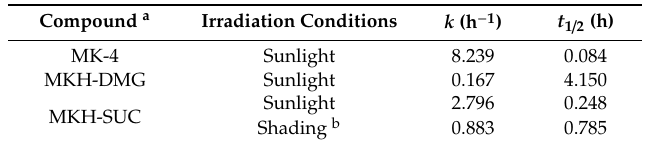
Figure 2. Photostability of MK-4 and MKH derivatives (1 µ M in ethanol) in artificial sunlight (12,000 lx) at 25 °C. ( A ) ○ : MK-4 and ● : MKH-DMG; ( B) MKH-SUC with ( ◆ ) and without ( ◇ ) shading. Table 1. The apparent first order rate constants ( k ) and half-lives ( t 1 / 2 ) of degradation of MK-4 and MKH derivatives in ethanol under irradiation with artificial sunlight (12,000 lx) at 25 ◦